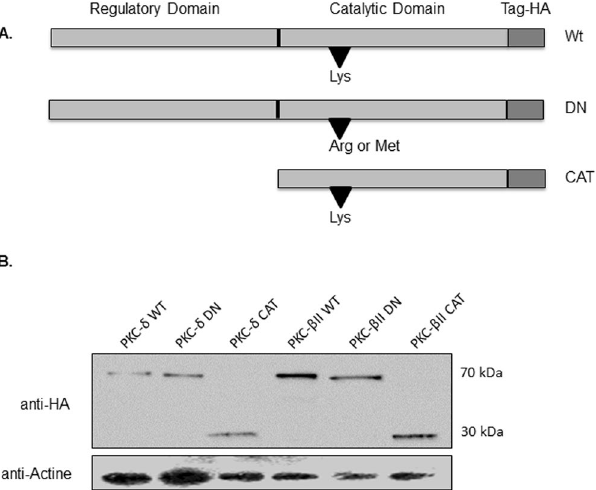
Figure 3. Control of PKC δ and β II expression. ( A ) schematic representation of PKC protein used in this study in either Wt, CAT of DN form. ( B ) HEK 293 T cell (10 6 cells) were lysed and then equal amounts of protein (20 μ g) were analysed by SDS-PAGE and western blot by using antibodies specific for HA-tag. Detection of Actine was used as a loading control. These results are representative of three independent experiments.